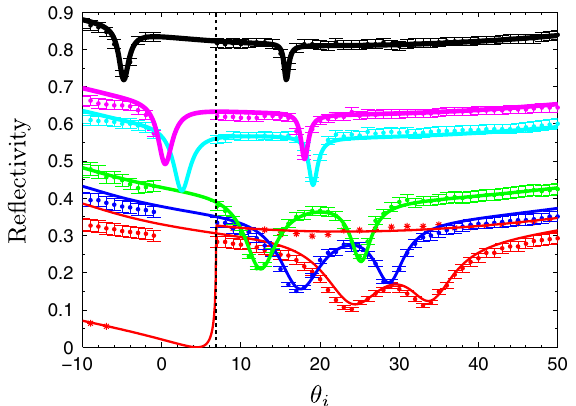
FIG. 4. Experimentally measured (dots) and theoretically cal- Þ from the SWABSiC ; (cid:1) culated (lines) reflectivity spectra R ð (cid:6) i k structure with the 2 a ¼ 6 (cid:2) m air gap. Colors (and linewidths from thin to thick) represent the wavelengths of the line-tunable 13 CO ¼ 10 : 723 (cid:2) m (red), (cid:1) ¼ 10 : 784 (cid:2) m (blue), 2 2 laser: (cid:1) 1 (cid:1) 3 ¼ 10 : 850 (cid:2) m (green), (cid:1) 4 ¼ 11 : 065 (cid:2) m (cyan), (cid:1) 5 ¼ ¼ 11 : 310 (cid:2) m (black). For 11 : 128 (cid:2) m (magenta), and (cid:1) 6 ð (cid:2) m Þ (cid:4) clarity, the spectra are vertically offset by the value (cid:1) k (cid:1) 1 ð (cid:2) m Þ . A reflection spectrum from a bare prism (no SiC) is also included for (cid:1) 1 ; theory (red solid line reaching zero) and ¼ 6 : 8 (cid:2) experiment (red stars) are given. The dashed line at (cid:6) 0 i indicates TIR corresponding to the excitation of the luminous